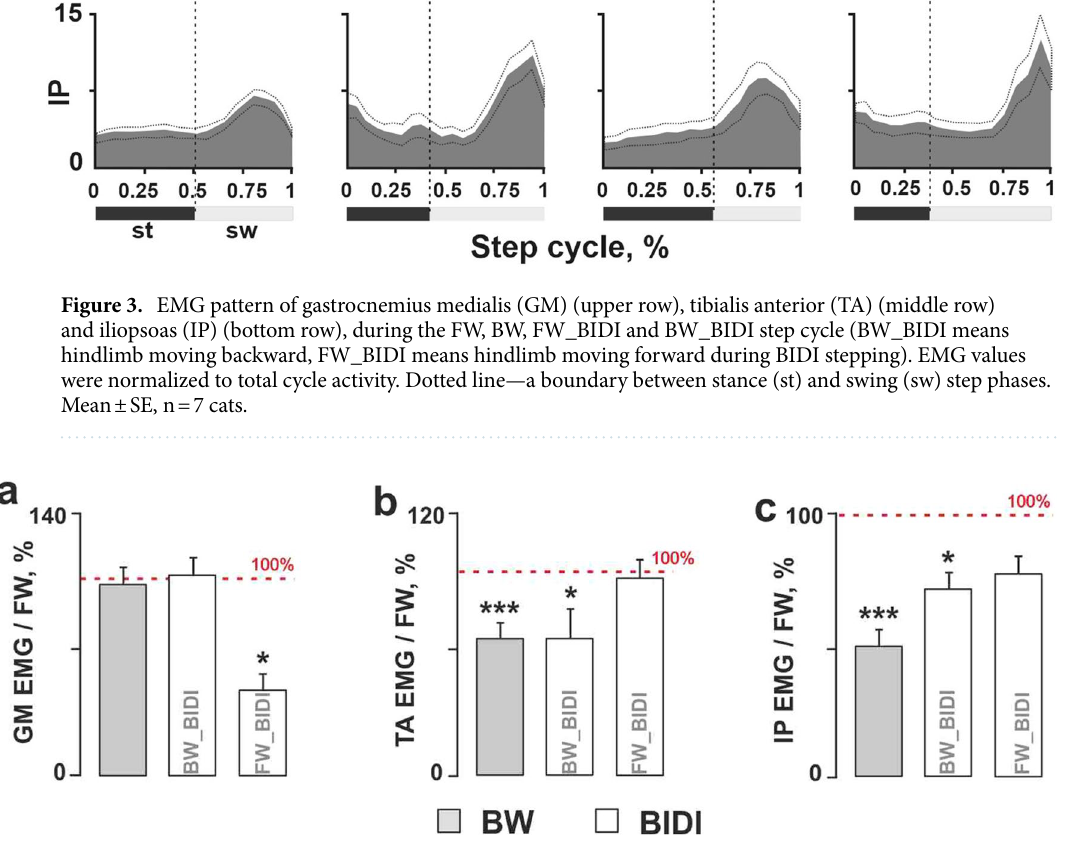
Figure 4. ( a – c ) The relative muscle activity calculated as the ratio of maximum muscle activity during BW or BIDI step cycle relative to the maximum muscle activity during FW step cycle (BW_BIDI means hindlimb moving backward, FW_BIDI means hindlimb moving forward during BIDI stepping). ( a ) Gastrocnemius medialis (GM). ( b ) Tibialis anterior (TA). ( c ) Iliopsoas (IP). Significant difference from FW mode or between the conditions: * p < 0.05, *** p < 0.001 , mean ± SE, n = 7